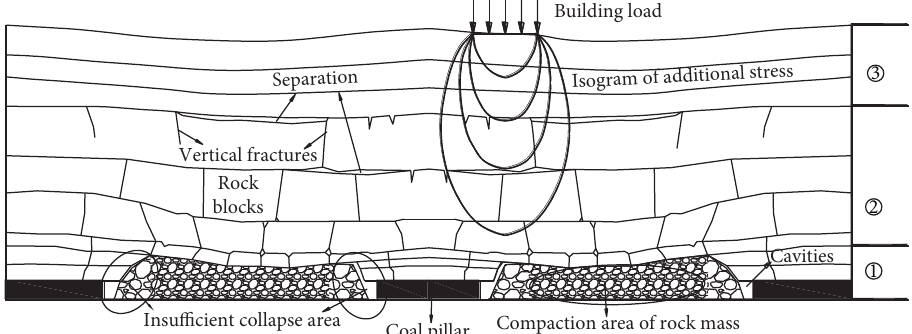
Figure 1: Zones of overlying strata in longwall mining. ① Caved zone; ② fracture zone; ③ continuous deformation zone (modified from